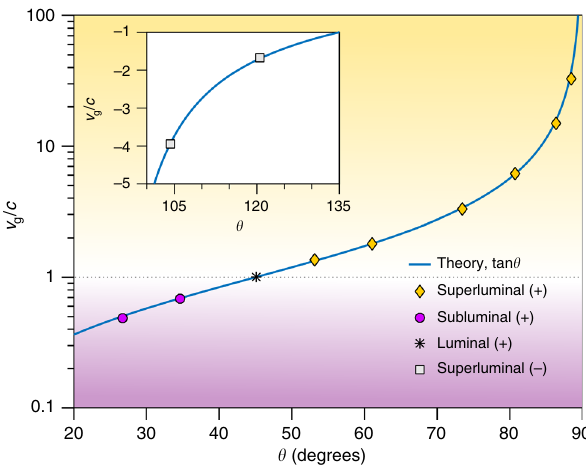
Fig. 4 Measured group velocities for space-time (ST) wave packets. By changing the tilt angle θ of the spectral hyperplane Pð θ Þ , we control v g of the synthesized ST wave packets in the positive subluminal and superluminal regimes (corresponding to 0 < θ < 90°). We plot v g on a logarithmic scale. Measurements of ST wave packets with negative- v g (corresponding to θ > 90°) are given as points in the inset on a linear scale. The data in the main panel and in the inset are represented by points and both curves are the theoretical expectation v g = c tan θ . The error bars are obtained from the standard error in the slope resulting from linear regression fi ts (see Methods and Supplementary Fig. 4). The error bars for the measurements are too small to appear, and are provided in Supplementary Table